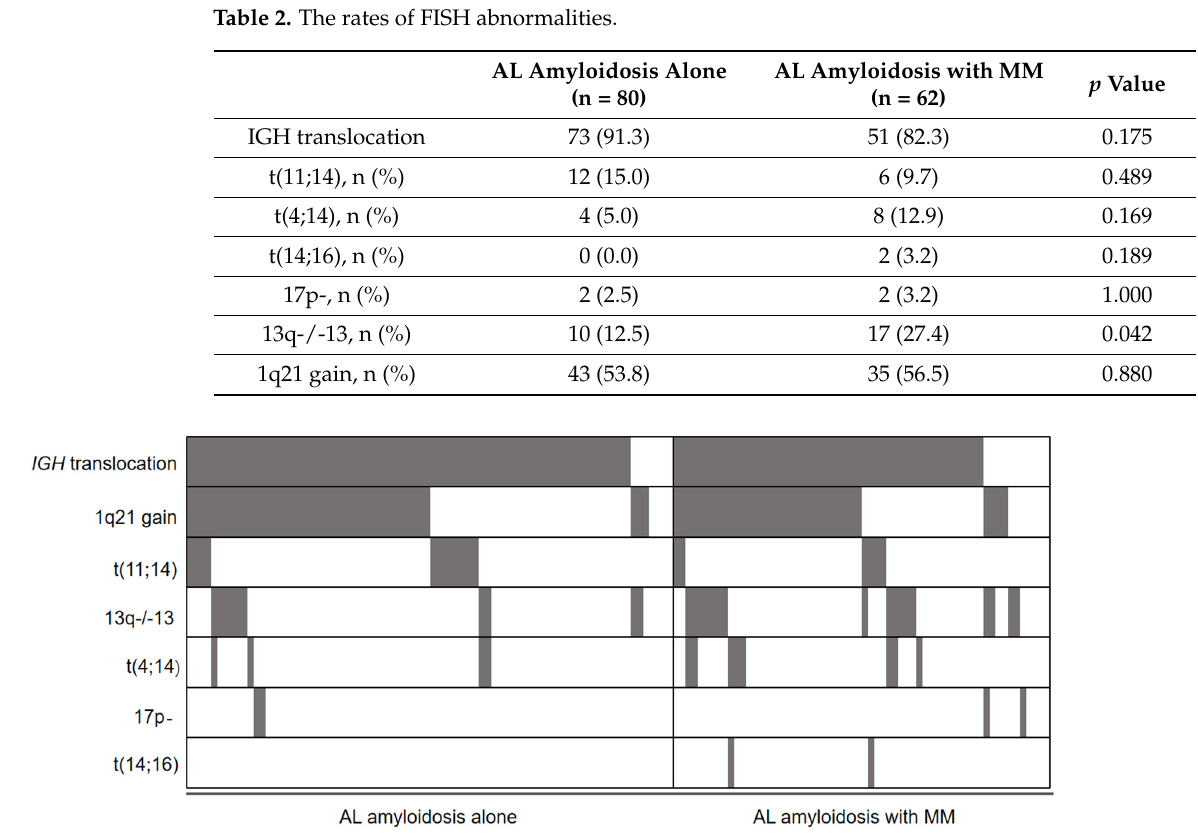
Figure 1. Distributions of FISH abnormalities. Gray shadow indicates positive results. Table 2. The rates of FISH